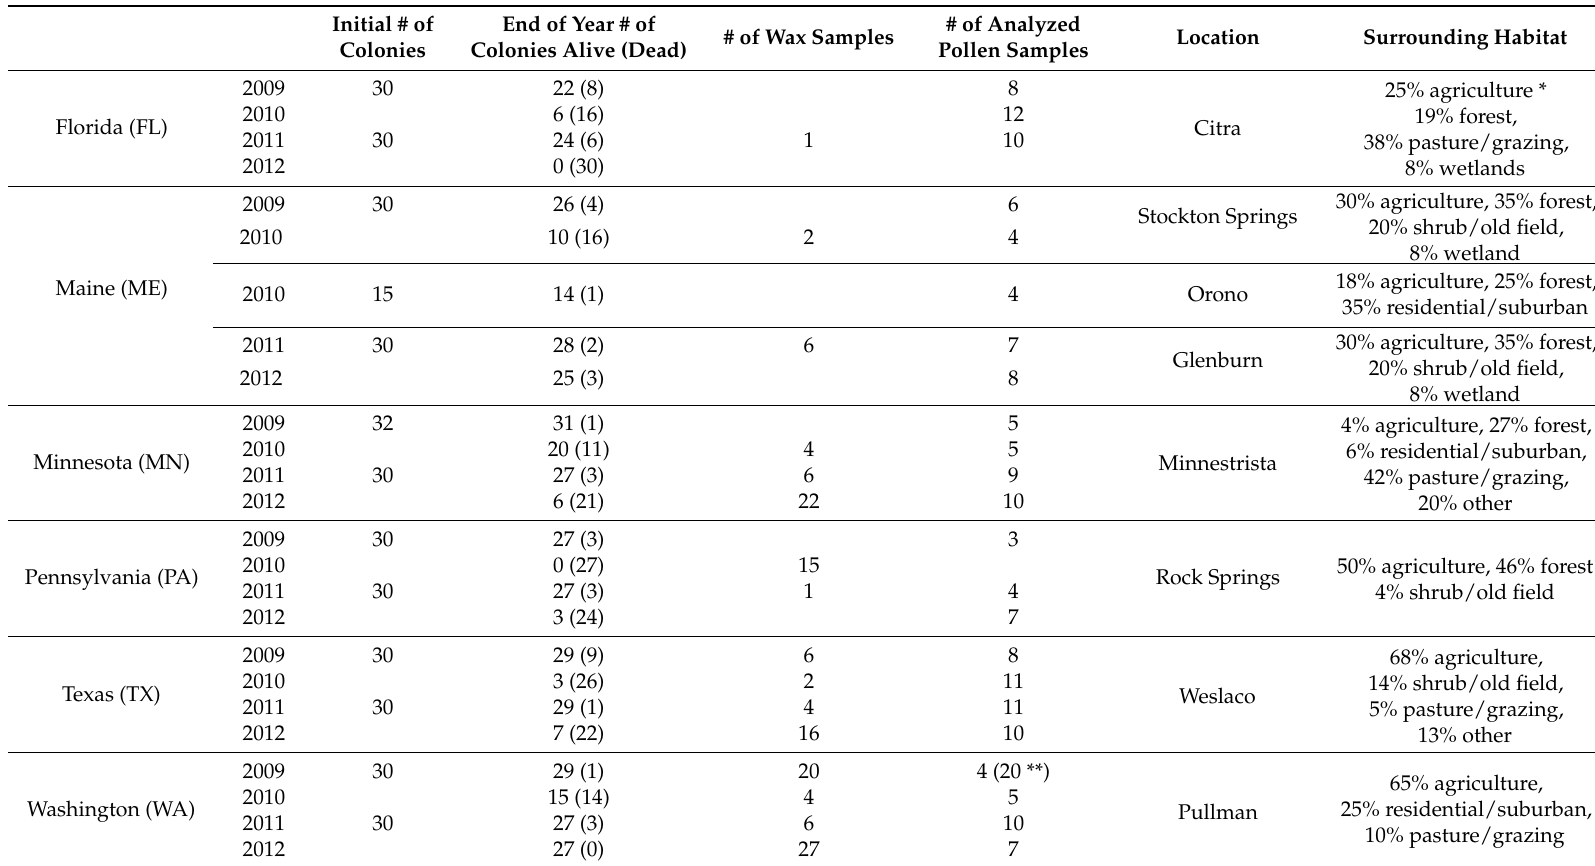
* Agriculture land was vegetable, fruit and field crops. ** Twenty pollen samples were taken from five hives. These pollen samples were not